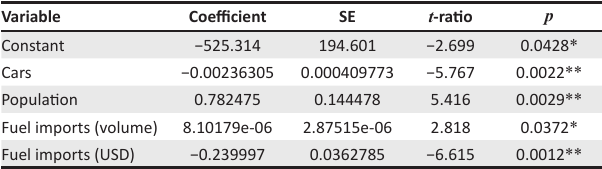
TABLE 3a: Fatalities ordinary least squares model. Variable Coefficient SE